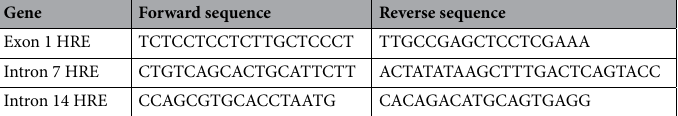
Table 2. Primer sequences for ChIP